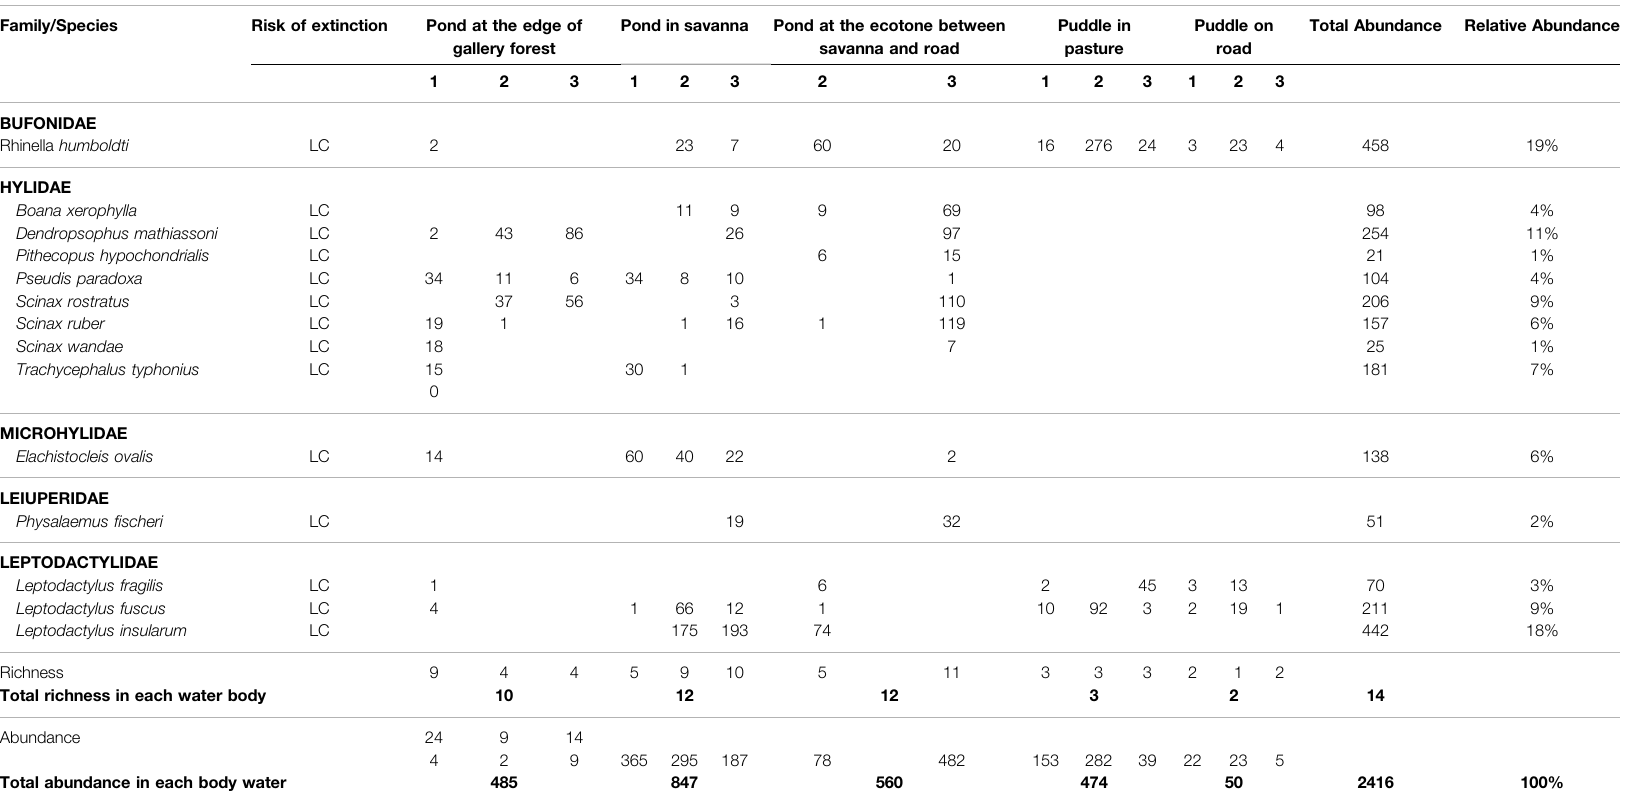
TABLE2| Composition,richness,andabundanceofanuransinlarvaldevelopmentalstagefoundin fi vebodiesofwaterintropical fl oodedsavannaoftheYopalMunicipality(CasanareDepartment,Colombia).Onthesecond row, under the name of the type of each body of water, the numbers represent the surveyed month, in which 1 is the beginning of the rainfall seasons and 3 is the month with the highest precipitation; representing a temporal dynamic of water accumulation in the bodies of water. Family/Species